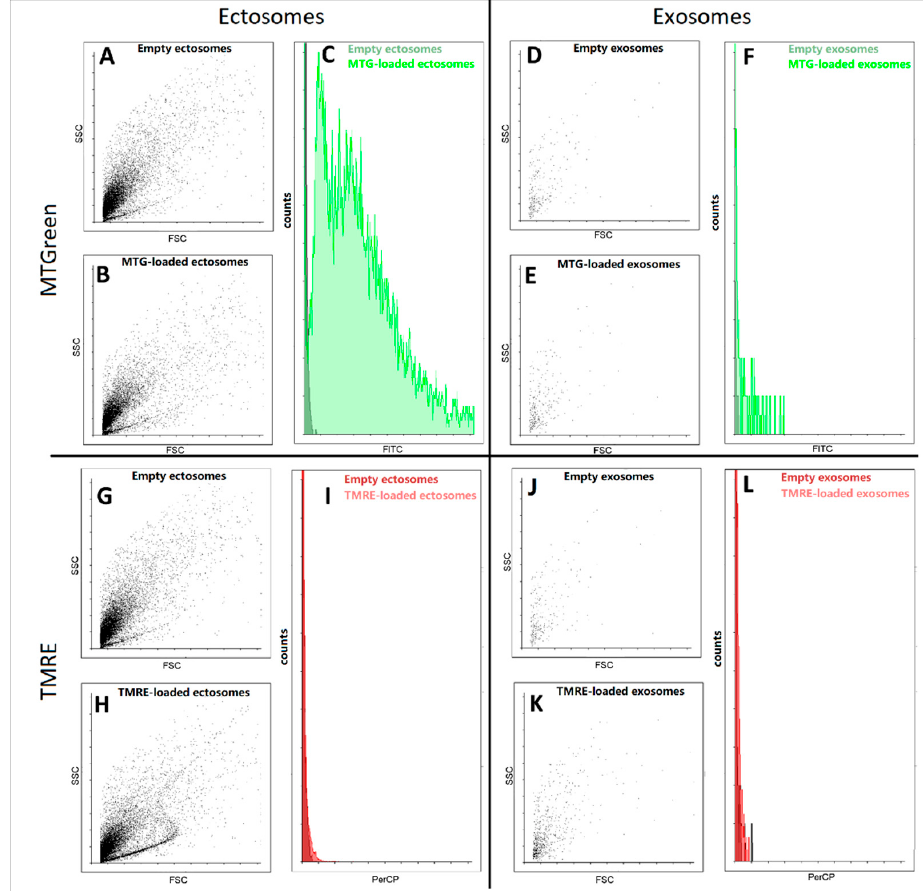
Figure 6. Analysis of the mitochondrial probe levels in various types of EV (ectosomes and exosomes) by flow cytometry. (( A – C , G – I ), ectosomes; ( D – F ,J– L ), exosomes). Dot-plots of unstained EV (empty vesicles) and EV loaded with MitoTracker Green (MTG, ( A – F )) and TMRE ( G – L ) are presented. ( C , F , I , L ) Histograms of the distribution of fluorescent responses for EV loaded with MTG and TMRE on the right side of dot-plots are shown (dark green and dark red, empty EV and light green and light brown are EV loaded with MTG and TMRE correspondingly).